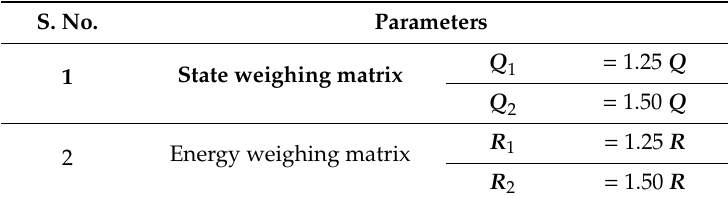
Table 6. Details of weighing matrices used for robustness analysis.